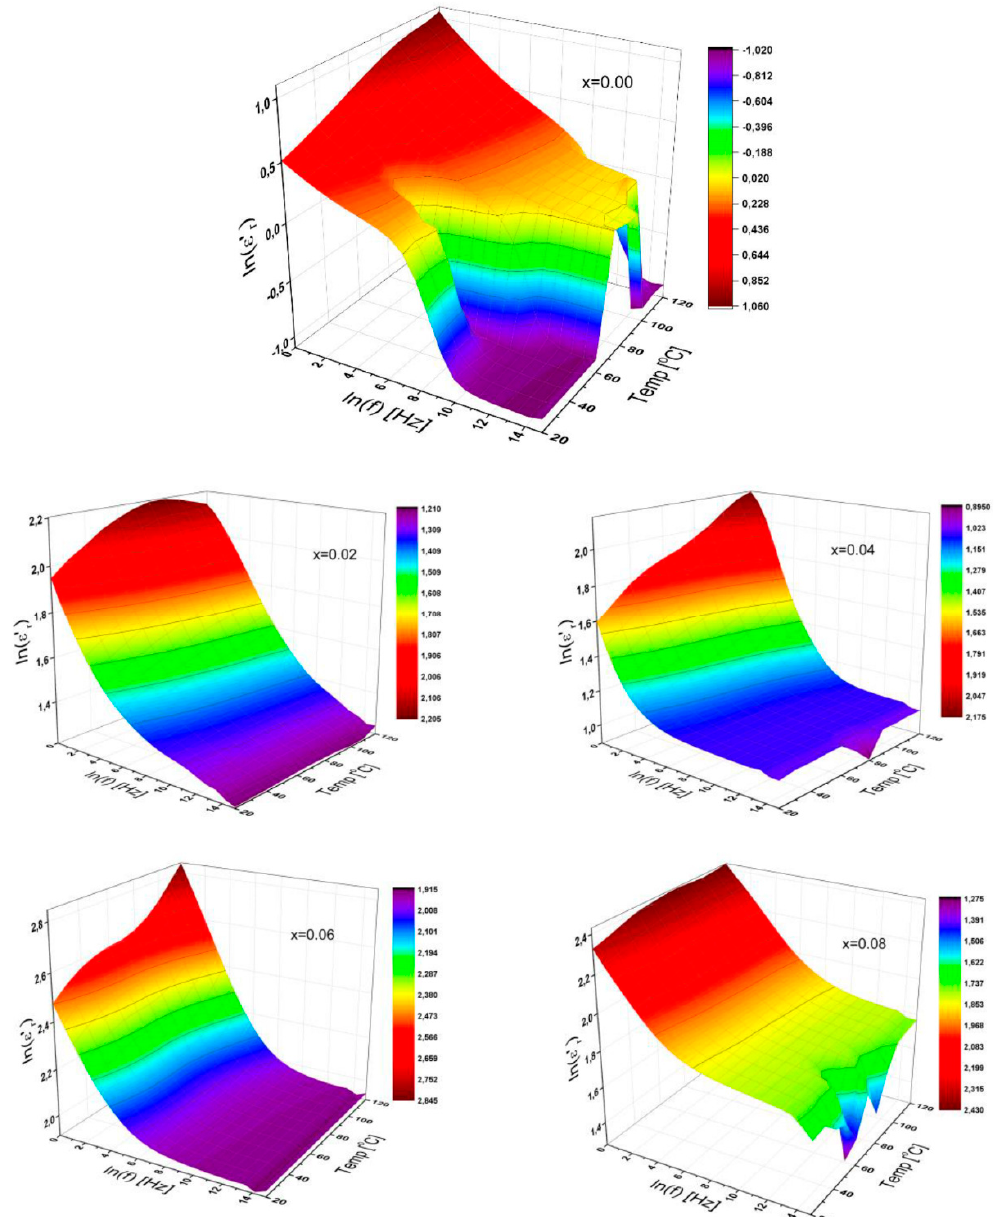
Figure 5. 3D characteristic plots of dielectric constant of SrNb x Fe 12 − x O 19 (0.00 ≤ x ≤ 0.08) HFs for a variety of substitutional Nb ions ratio as functions of frequency up to 3 MHz, and for temperatures up to 120 ° C.